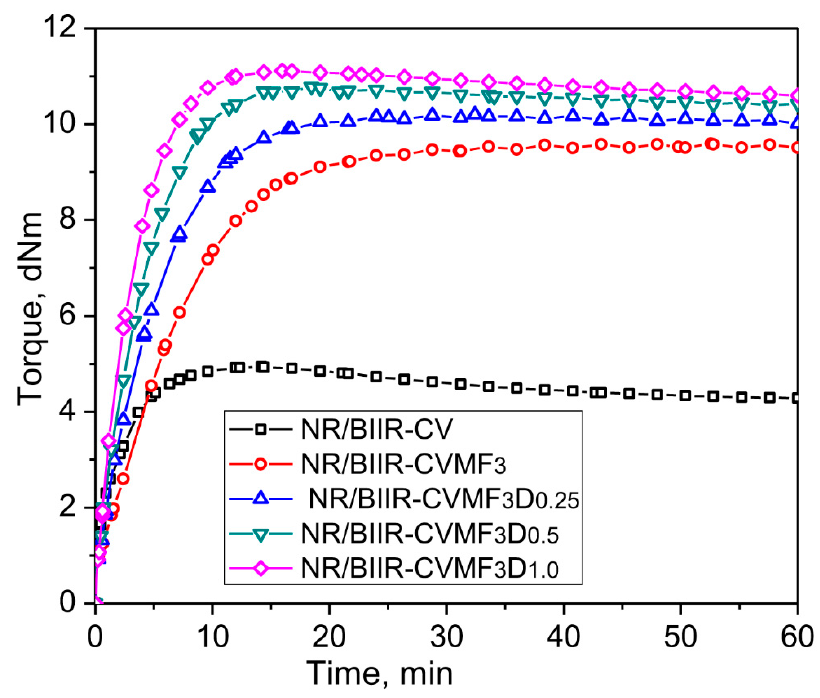
Figure 5. Curing curves of NR/BIIR-CVMF3 with different contents of DCP at 170 °C for 1 h. The ∆ torque of NR/BIIR-CVMF 3 gradually increased as the content of DCP increased. This indicates that the overall network strength of the blend was enhanced. Moreover, the speed of the curing reaction increased as the content of DCP increased. As a result, the T 90 of NR/BIIR-CVMF 3 could be reduced from 15.7 min to just 7.15 min when cured with 1phr of DCP. It is interesting to note that NR/BIIR-CVMF 3 and NR/BIIR- CVMF 3 D 0.25 exhibited a plateau-type curing behavior without any reversion until the end of the given curing time. However, as the content of DCP increased to 0.5 phr, a declina- tion in the cure curve was observed after 19 min of curing with a reversion of around 3.6%